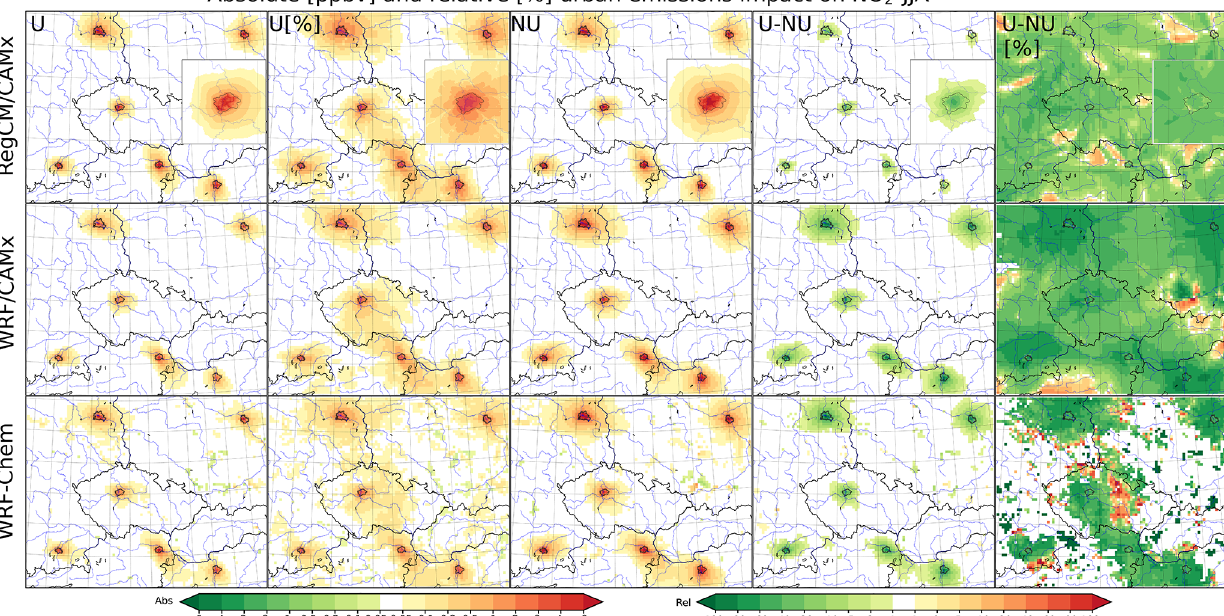
Figure 5. Same as Fig. 4 but for